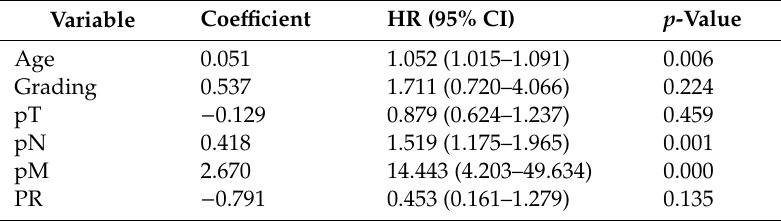
Table 4. Multivariate Cox regression analysis of unifocal patients regarding OS.